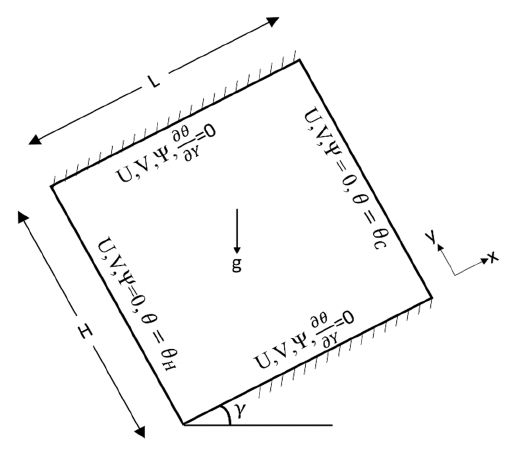
Figure 1. Geometry and Coordinate system for square domain.